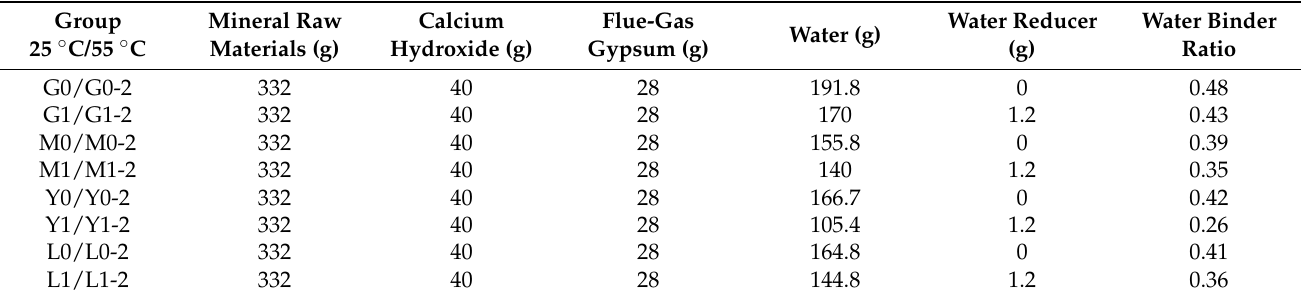
Table 5. Content of each sample